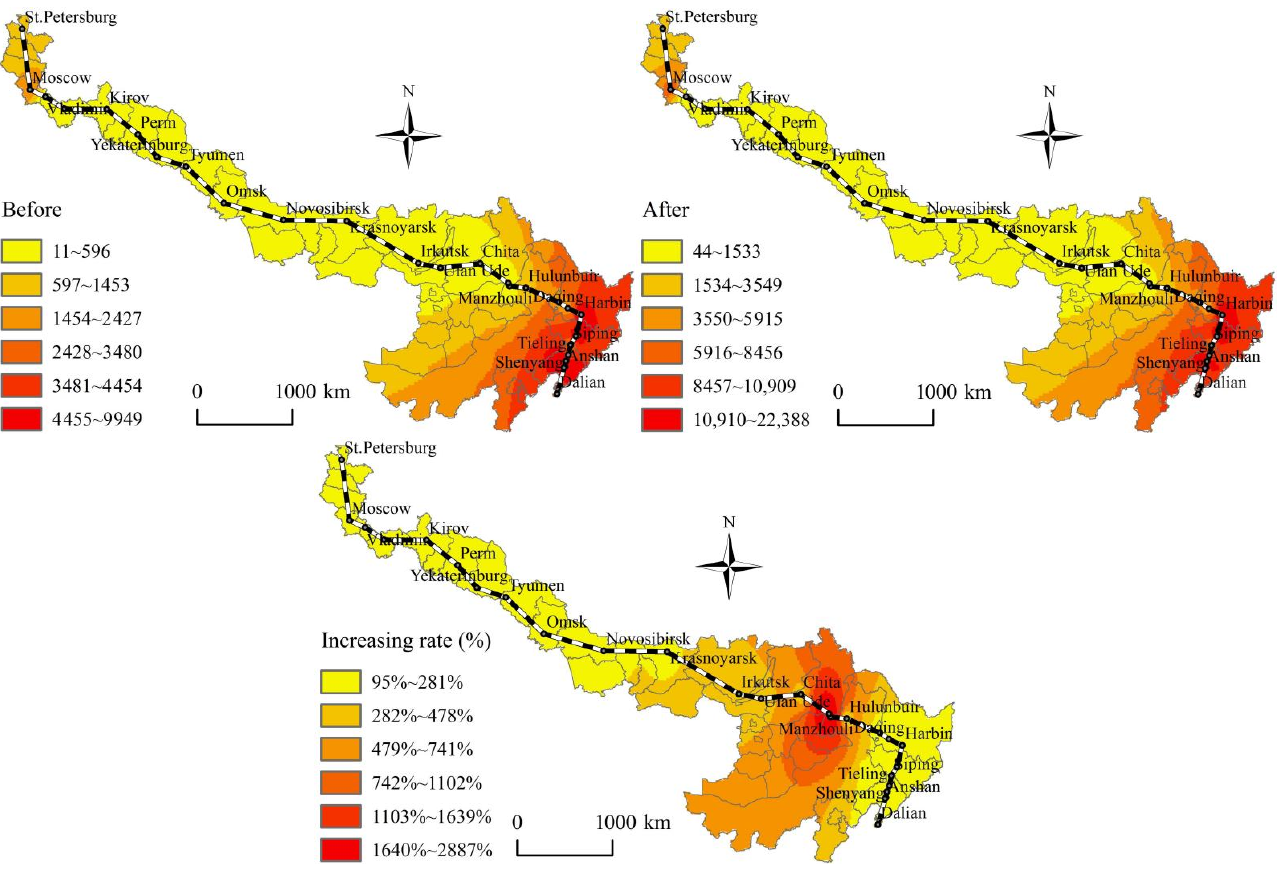
Figure 5. Spatial pattern changes of the economic potential before and after the China-Mongolia- Russia HSR east line opening.